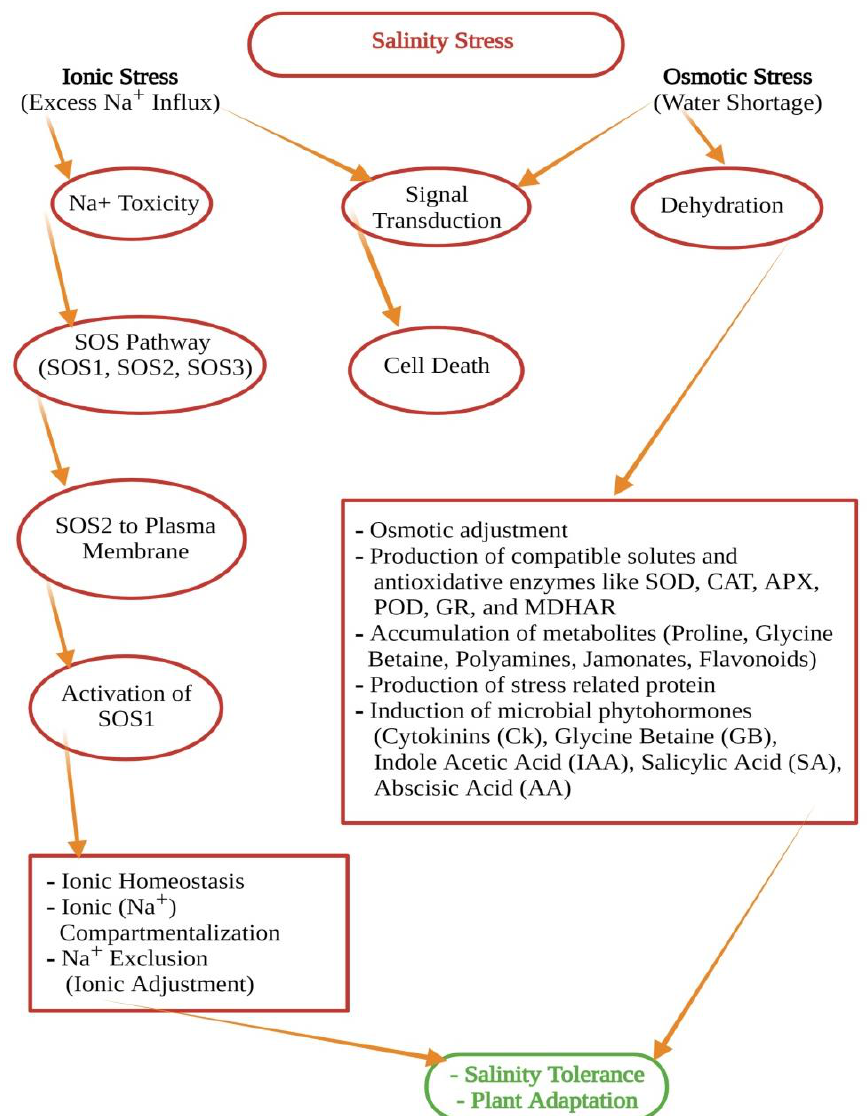
Figure 5. A generalized schematic representation of salt stress in plants leading to ionic and osmotic stress and the resulting tolerance mechanisms including the SOS signaling pathway, ionic homeostasis, osmotic adjustment, the production of metabolites and compatible solutes, rhizosphere microbial activities, and the production of phytohormones to alleviate various stresses, especially salt stress in plants.